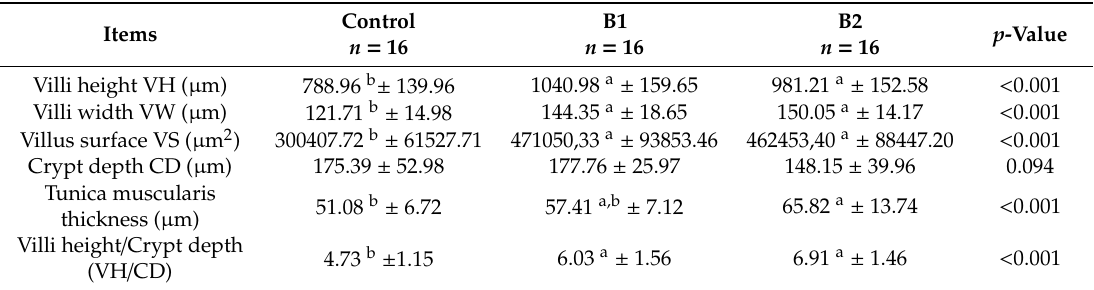
Table 4. The e ff ect of prebiotic Bi2tos ® on histological measurements of intestines of common carp ( Cyprinus carpio L.).